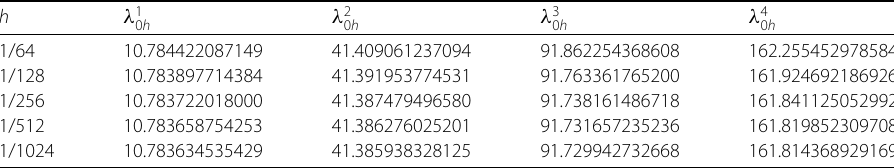
Table 4 a = 0, the four eigenvalues with l = 0 and h h